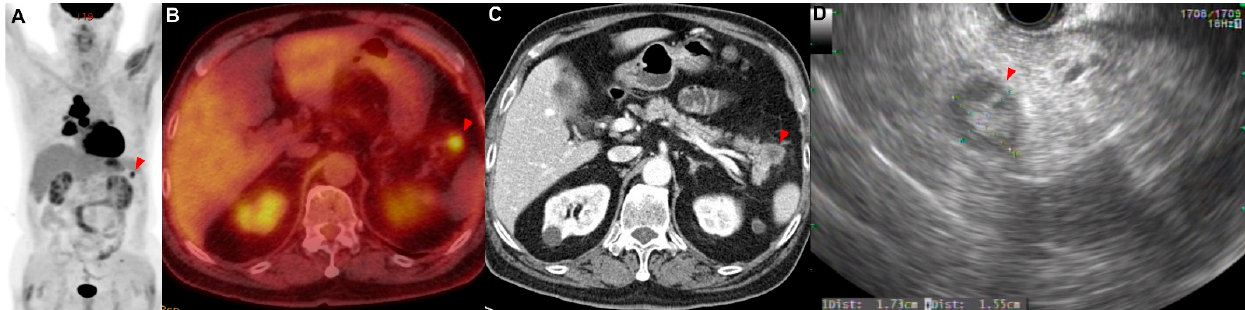
Figure 1. Patient 1: a 71-year-old man diagnosed with non-small-cell lung cancer (NSCLC) with a solitary metastasis in the tail of the pancreas. ( A – C ) Positron emission tomography/computed tomography (PET/CT) showed a solitary metastatic lesion (red arrowhead) in the tail of the pancreas. ( D ) EUS-FNA was performed at the metastatic lesion (red arrowhead) in the